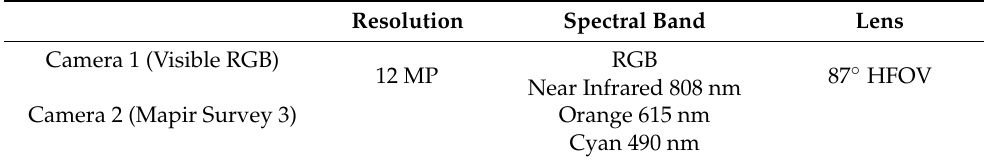
Figure 3. Study site location; ( a )—OCN camera image with 45 ◦ angle; ( b , c )—photos of the slopes from railway track. Table 2. The attributes of cameras